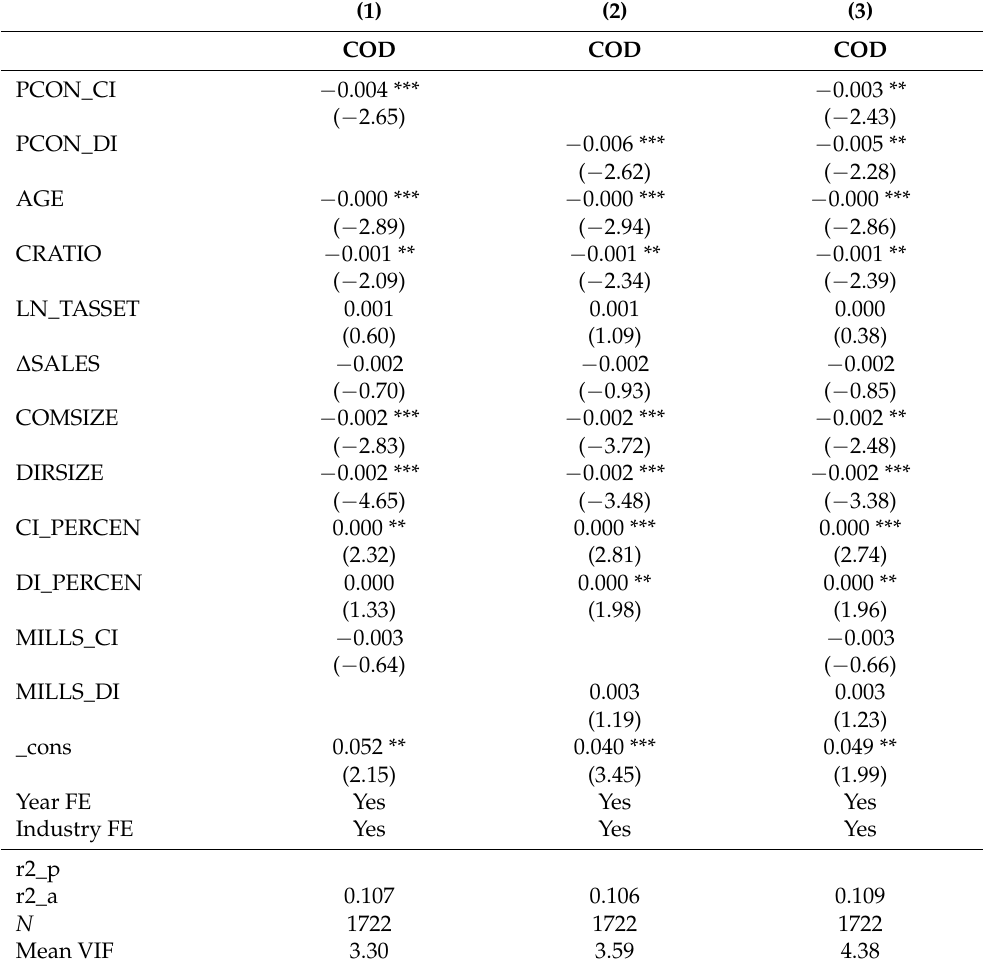
Table 11. Results of Second-Stage Regression, Heckman